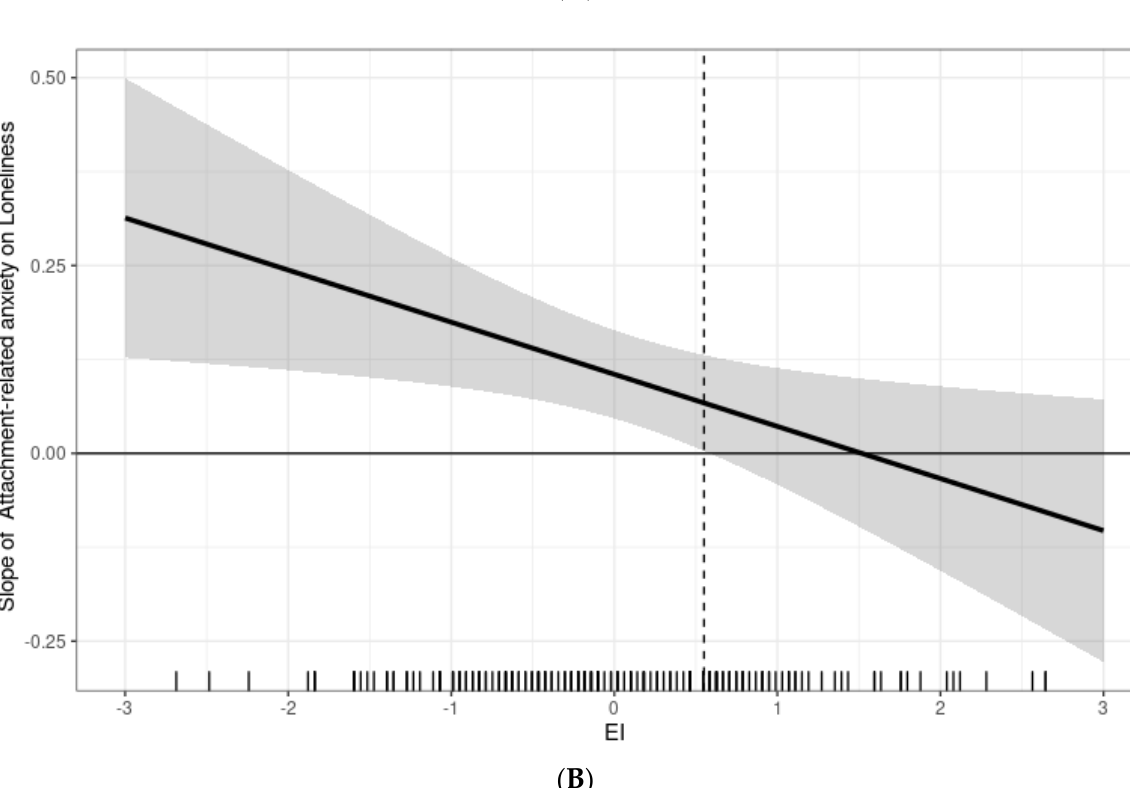
Figure 5. Graphical representation of the moderation analysis in Study 2. The interaction between attachment-related anxiety and EI in predicting loneliness (panel ( A )) and Johnson–Neyman regions representing the threshold of significance for the effect of attachment-related anxiety on loneliness at different levels of EI (panel ( B )). Note. The figures were generated using the interActive data visualization tool. The shaded regions in panel B indicate 95% confidence intervals. The effect of attachment-related anxiety on loneliness is statistically significant left of the dashed vertical line (the confidence bands there do not include zero).